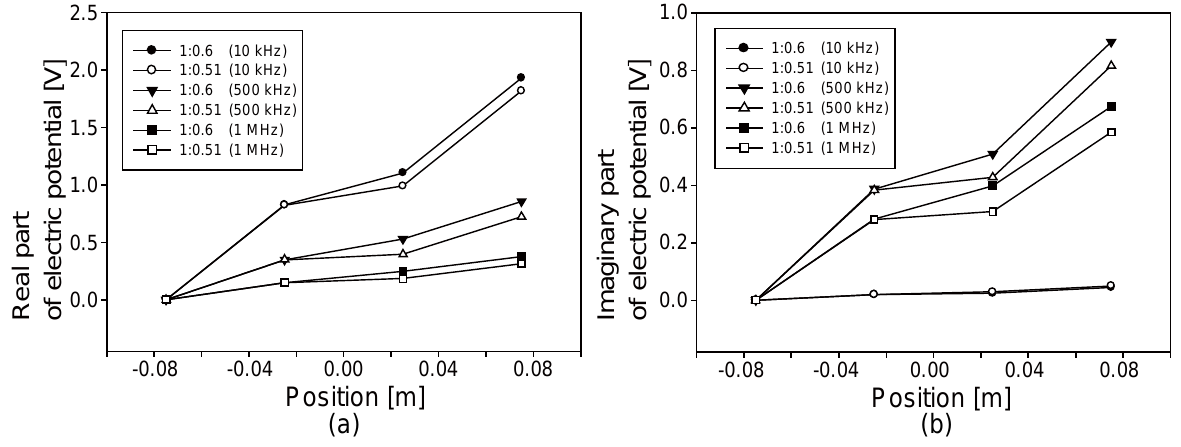
Figure 5. Changes of the computed electric potentials along the middle horizontal line: ( a ) real and ( b ) imaginary